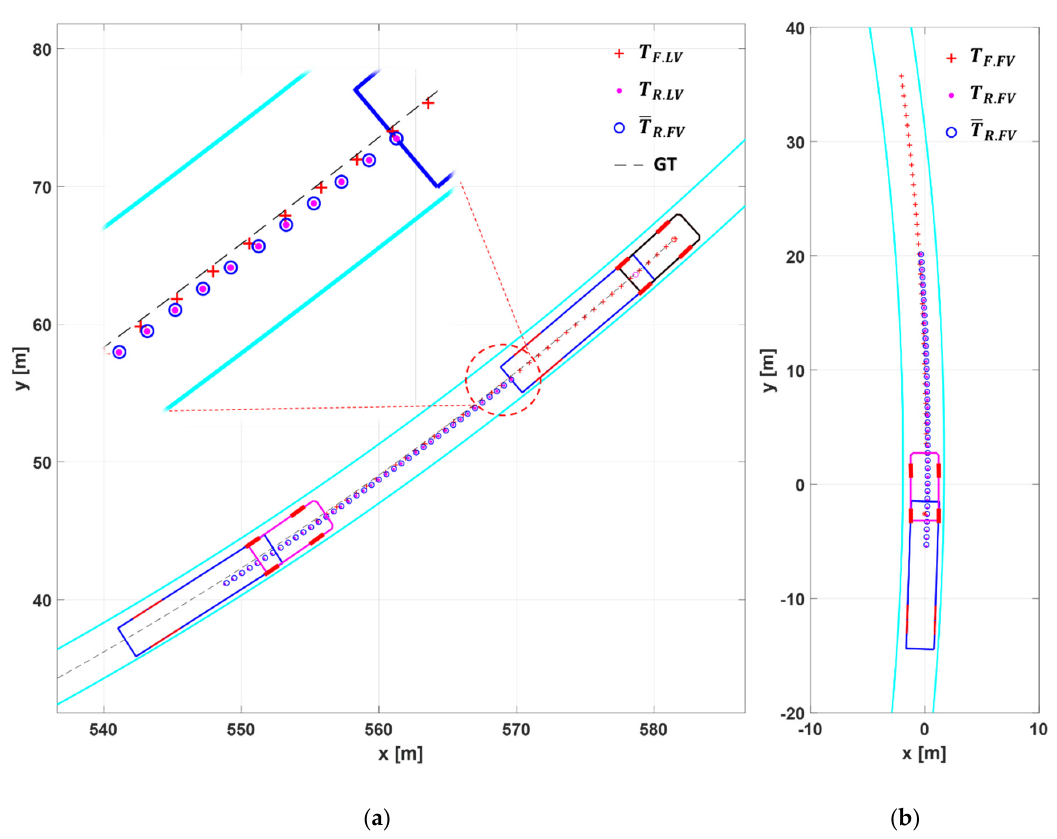
Figure 19. The simulation results for Scenario S2 ( a ) T F . LV , T R . LV , and T R . FV in LV and FV; ( b ) T F . FV , T R . FV and T R . FV in FV.